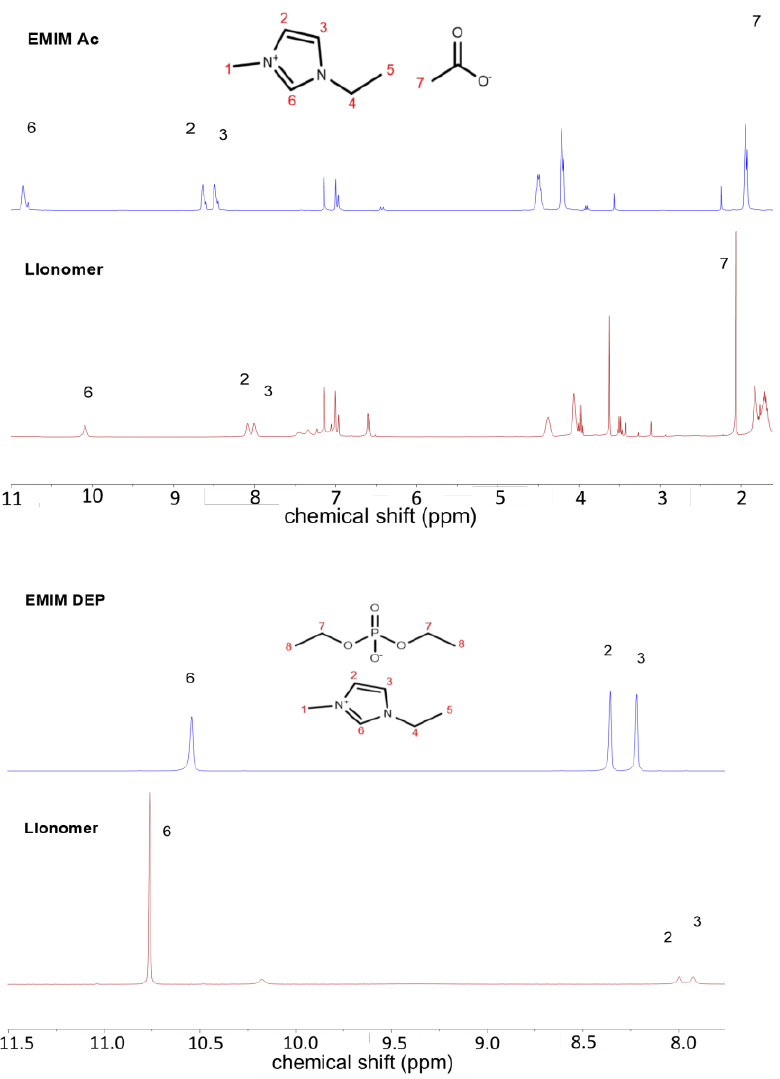
Figure 3. 1 H NMR spectra (400 MHz; C6D5Cl solvent) of ILs and related LIonomers materials (10 wt.% IL).